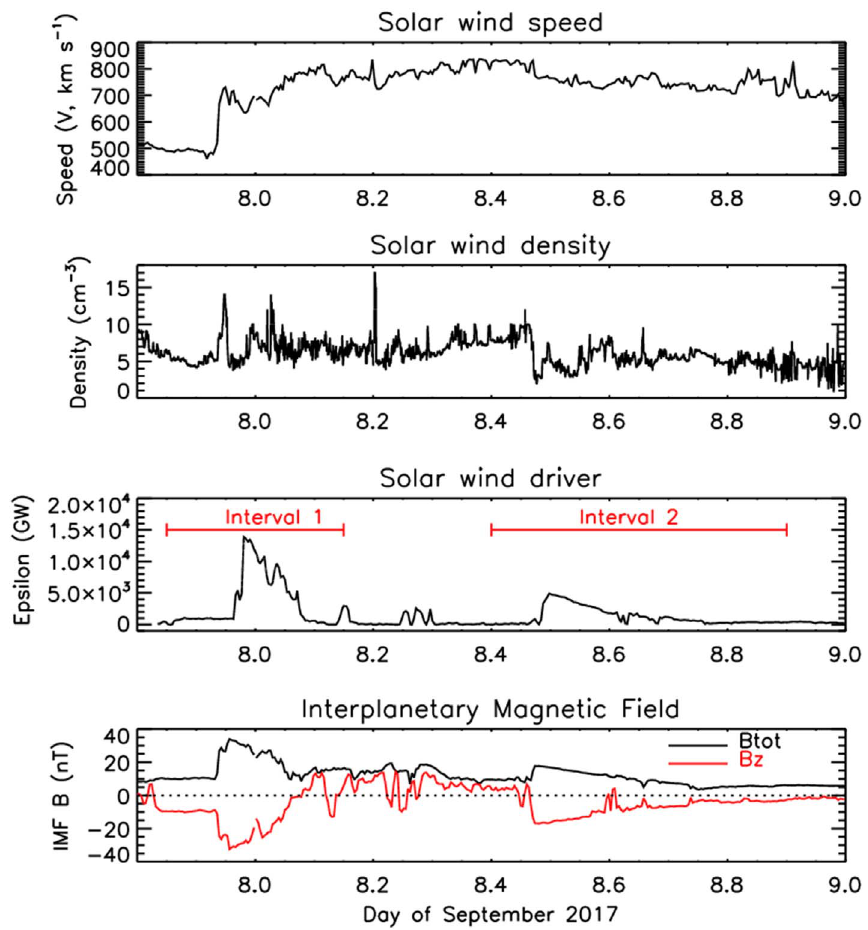
Fig. 1. A summary plot of the solar wind and geomagnetic conditions during the disturbed period in September 2017. DSCOVR solar wind speed and density are shown in the upper two panels, solar wind epsilon factor and IMF magnetic fi eld components ( B tot and B z ) in the lower two